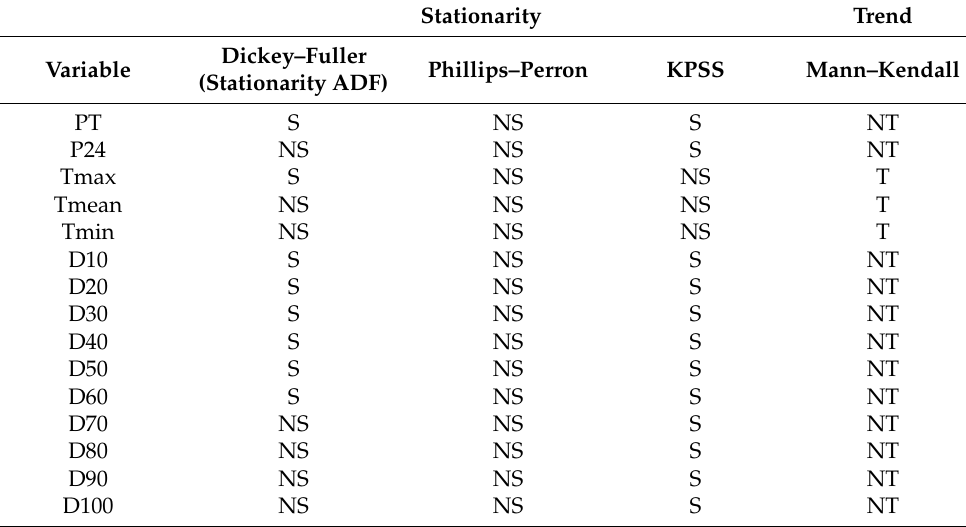
Table 4. Test of stationarity and trend of the original